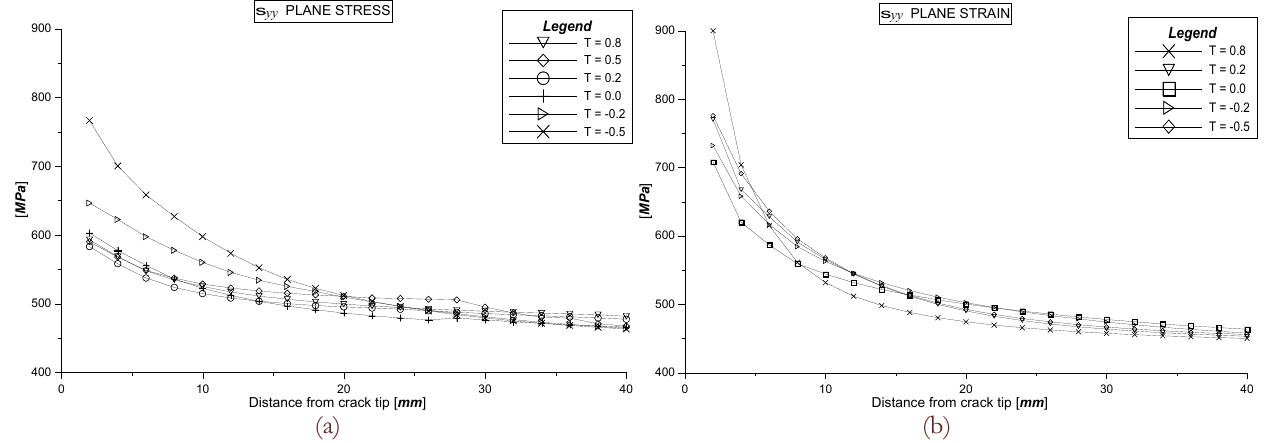
Figura 3: Valori di σ yy in tensione piana (a) e in deformazione (b) per diverse tipologie di